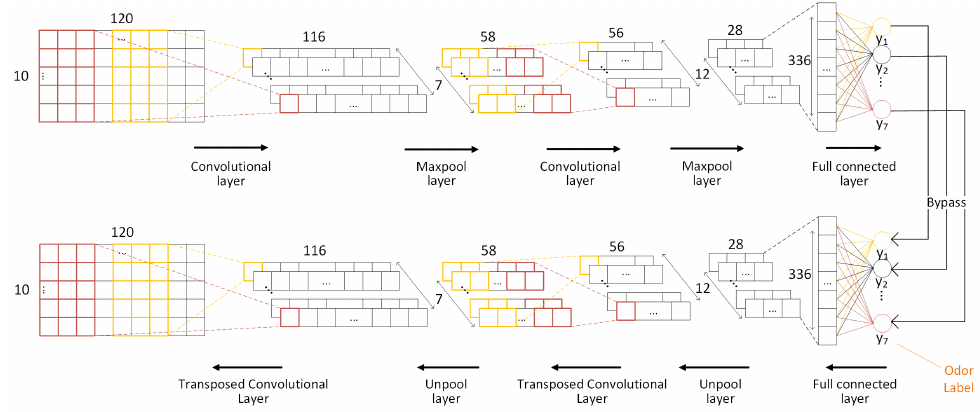
Figure 4. Architecture of the odor labeling convolutional